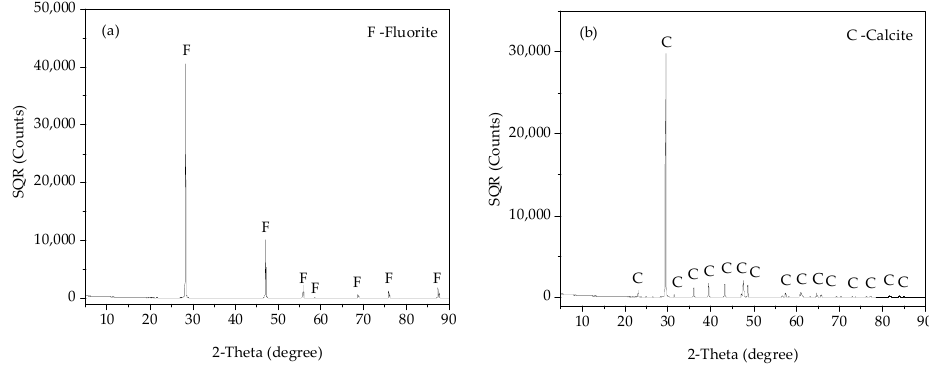
Figure 1. X-ray diffraction patterns of ( a ) pure fluorite and ( b ) pure calcite samples. All reagents used in this study were analytical grade, and deionized water was used throughout the experiment. Sulfuric acid (0.1 mol/L) and sodium hydroxide (0.1